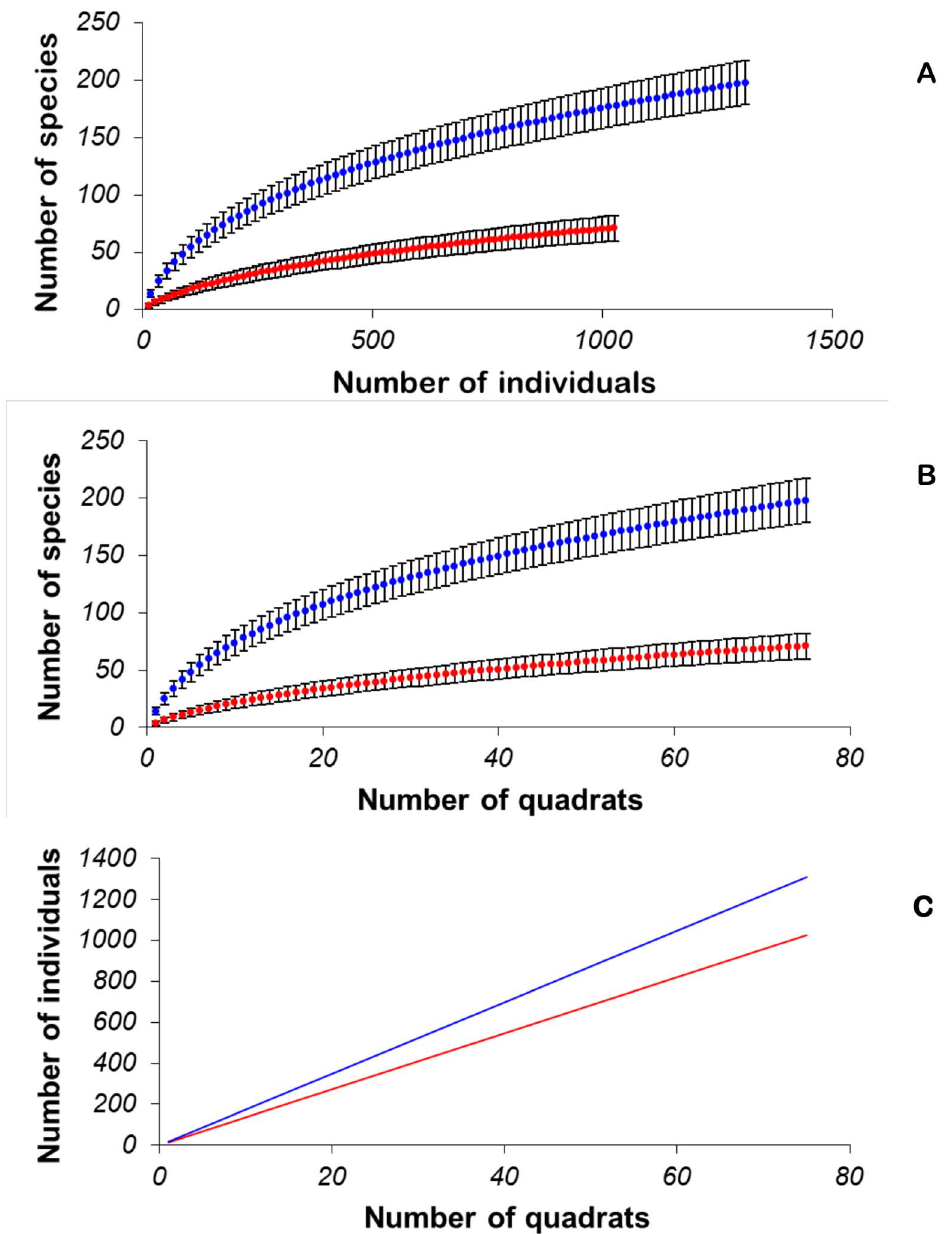
Figure 3. Sample-based rarefaction curves of the tree communities found in monodominant Gilbertiodendron forests (red dots and line) and mixed forests (blue dots and line) comparing number of species (A), species density (B) and population density (C). Error bars represent 95% confidence interval.